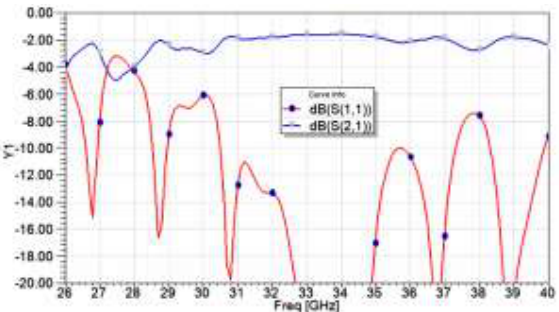
Figure 10: Simulated full WR28 band SPC reflection coefficient and losses in dB.